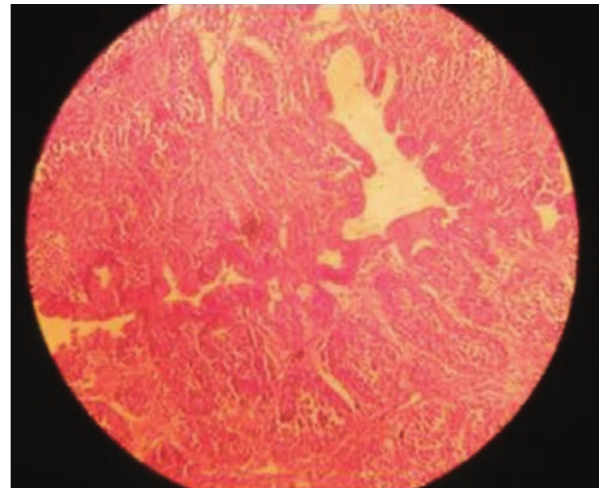
Figure 4: Proventriculus of stunted